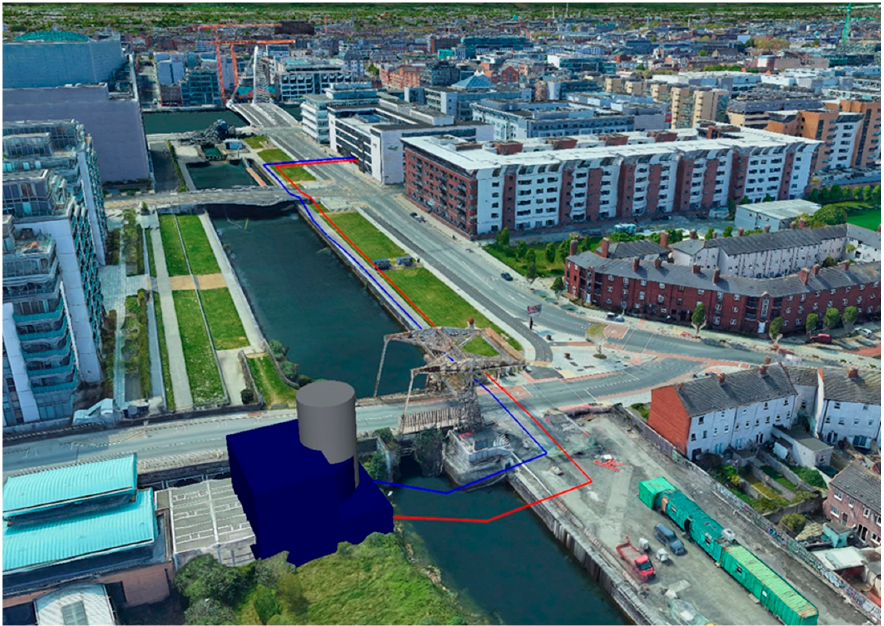
Figure 6. Depiction of a district energy plant located on the canal that uses a closed loop system to meet the summertime cooling needs of offices.